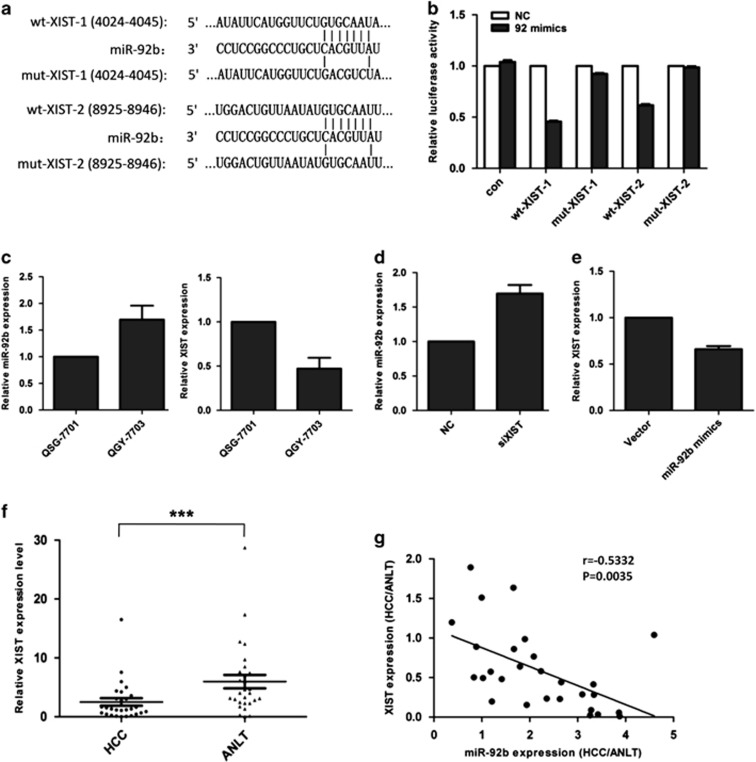
Reciprocal repression between XIST and miR-92b in HCC cells. (a) Diagram of the two miR-92b putative binding sites and corresponding mutant sites in XIST mRNA sequences. (b) Effects of miR-92b on the expression of reporter genes containing XIST-1 or XIST-2 sequences. Each luciferase activity was normalized to the value obtained in the cells transfected with NC mimics. (c) Relative miR-92b (left panel) or XIST expression (right panel) of QSG-7701 and QGY-7703 cells were analyzed by qRT-PCR. The data were normalized against the expression level of miR-92b or XIST in QSG-7701 cells. (d) Relative miR-92b expression in QGY-7703 cells transfected with XIST siRNA or NC siRNA were analyzed by qRT-PCR. The data were normalized to the expression level of miR-92b in the cells transfected with NC siRNA. (e) Relative XIST expression in QGY-7703 cells transfected with miR-92b or NC mimics were analyzed by qRT-PCR. The data were normalized to the expression level of XIST in the cells transfected with NC mimics. Results were represented as mean±S.D. (n=3). (f) Expression of XIST in 28 pairs of female HCC tissues and ANLTs were determined by qRT-PCR. The expression levels were compared with paired Student's t-test. (g) The negative correlation between XIST and miR-92b expression in female HCC tissues (r=−0.5332, ***P=0.0035, n=28)